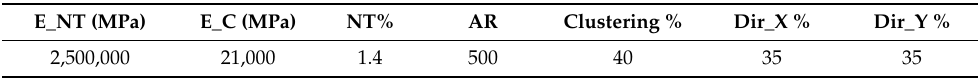
Figure 9. Impact of each parameter while the others are fixed for the nominal case. Table 9. Nominal case chosen. Table 9. Nominal case